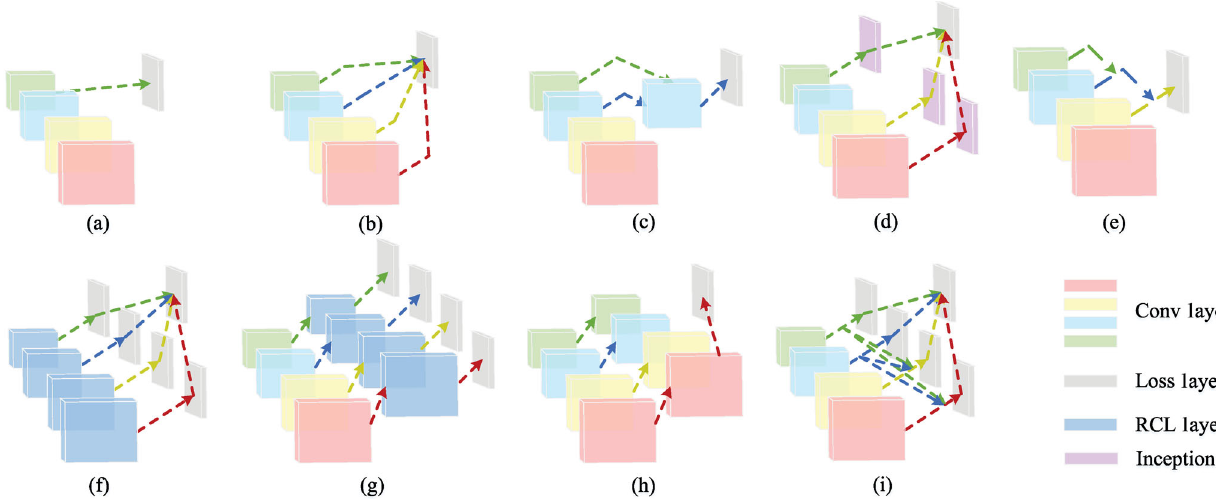
Fig. 4 Popular FCN-based architectures. Apart from the classical architecture (a), more and more advanced architectures have been developed recently. Some of them (b–e) exploit skip layers from different scales so as to learn multi-scale and multi-level features. Some (e, g–i) adopt an encoder–decoder structure to better fuse high-level features with low-level ones. Others (f, g, i) introduce side supervision as in Ref. [142] in order to capture more detailed multi-level information. See Table 5 for details of these